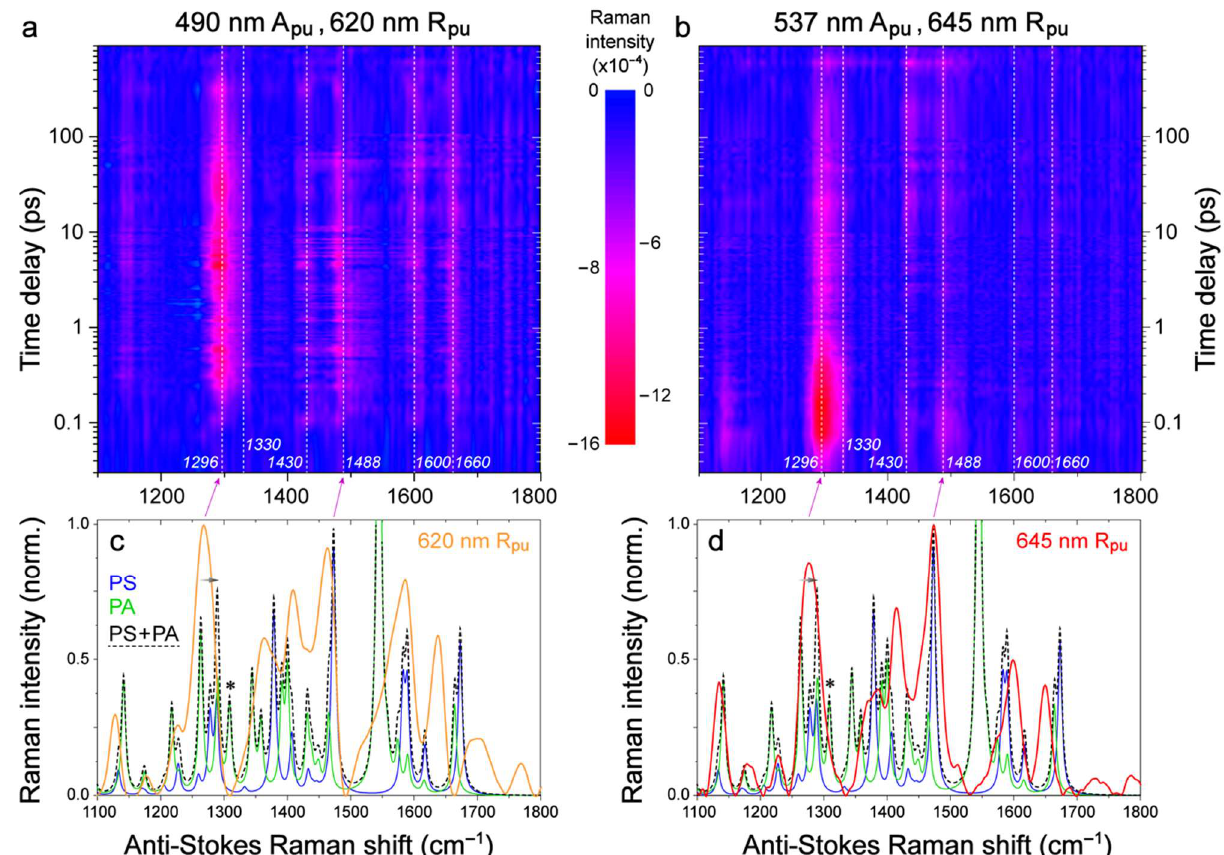
Figure 4. Femtosecond stimulated Raman spectroscopy (FSRS) of Draconin Red in DCM solvent from the electronic ground to excited states. The semilogarithmic 2D-contour plots of the excited-state (ES)-FSRS data ( a ) after a 490 nm actinic pump (A pu ) paired with a 620 nm Raman pump (R pu ), and ( b ) after 537 nm A pu paired with a 645 nm R pu . The Raman probe is on the bluer side of R pu to stimulate the Raman signal. The negative signal intensity color bar is shared in the middle. The prominent Raman peaks are highlighted by vertical white dashed lines with peak frequencies denoted. In lower panels, the corresponding ground-state (GS)-FSRS data are plotted in ( c ) and ( d ) with 620 nm R pu (solid orange line) and 645 nm R pu (solid red line), respectively, with the intensity multiplied by − 1 for comparison to the calculated spectrum with positive intensity. The calculated ground-state Raman spectra for PS tautomer (blue solid), PA tautomer (green solid), and their sum (black dashed line) are overlaid with the GS-FSRS for a direct comparison. An asterisk denotes a calculated PA-specific mode at ~1310 cm − 1 , while the horizontal gradient gray arrow highlights a characteristic PA → PS peak frequency blueshift in a prominent marker-band region. The upward tilted magenta arrows between panels ( c ) and ( a ), as well as panels ( d ) and ( b ), highlight the photoinduced Raman peak frequency blueshift from the electronic ground state to excited state (close to the Franck–Condon